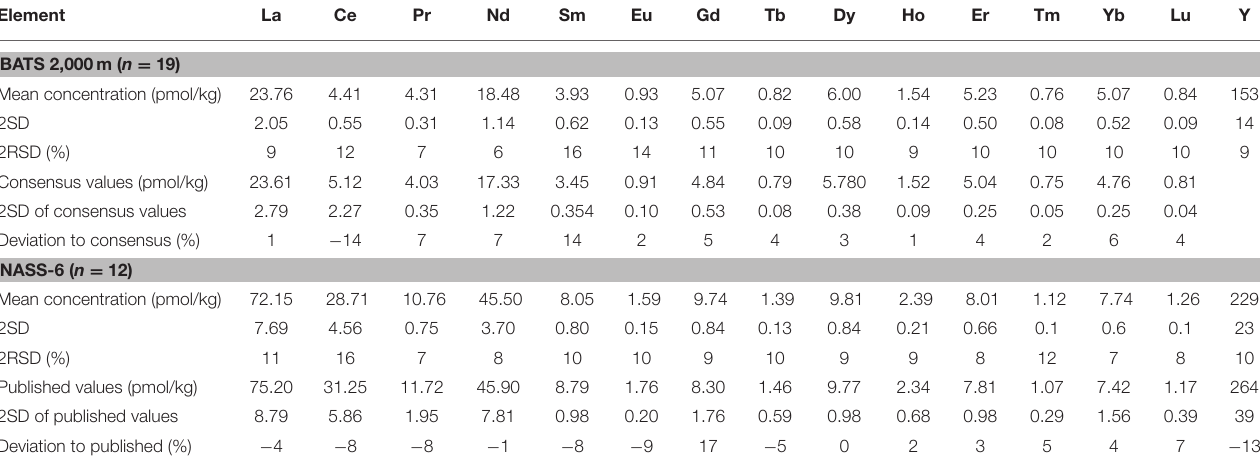
TABLE 2 | Dissolved REE concentrations in reference samples measured during the course of this study: consensus values of the GEOTRACES intercalibration seawater from the Bermuda time series station (BATS) 2,000m (van de Flierdt et al., 2012); published values of (Wang et al., 2014) for NASS-6 (National Research Council Canada) coastal